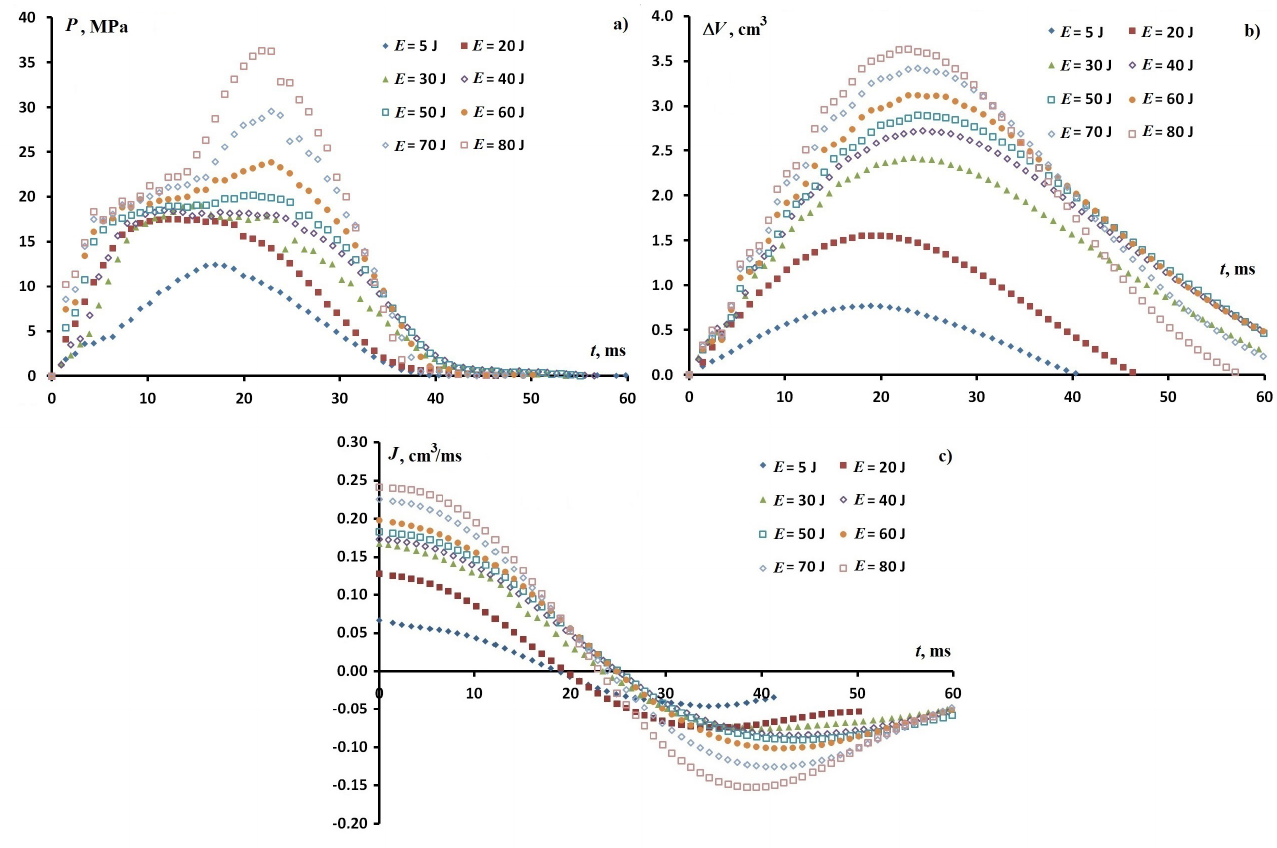
Figure 2. Time dependencies of the ( a ) pressure P , ( b ) volume change ∆ V , and ( c ) rate of the volume change J for the L23 (5 g) – DW (55 cm 3 ) system at impact energies 5, 20, 30, 40, 50, 60 , 70 and 80 J at 20 ◦